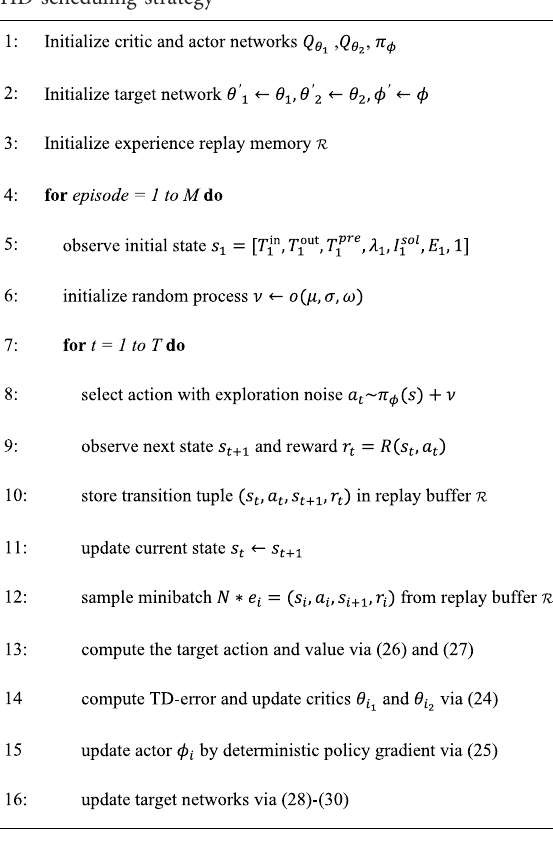
Algorithm 1. Training procedure of the proposed TD3-based EHD scheduling